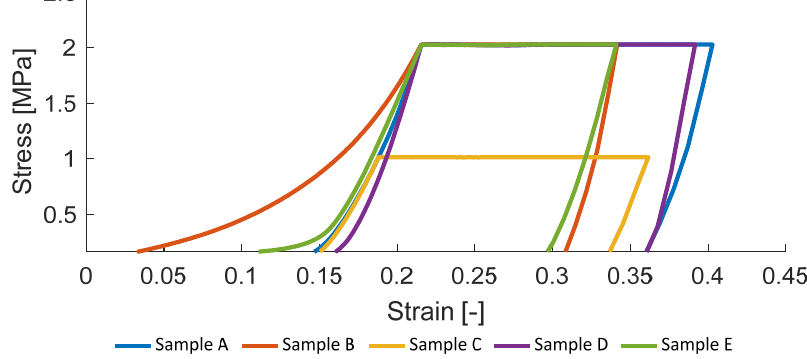
Figure 7. Measured stresses depending on strain for samples A–E.